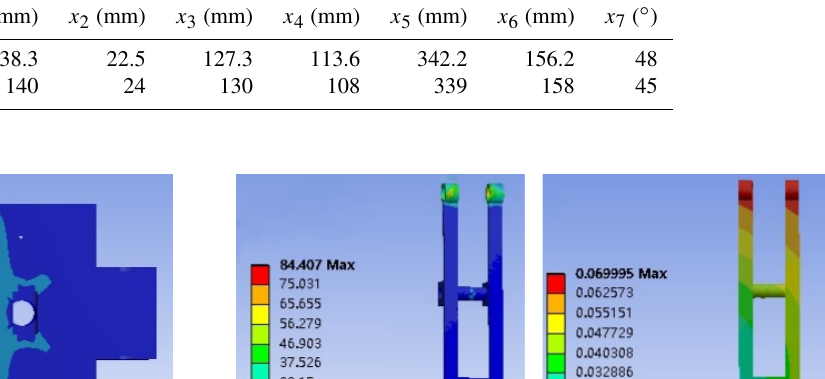
Table 1. The optimization results.